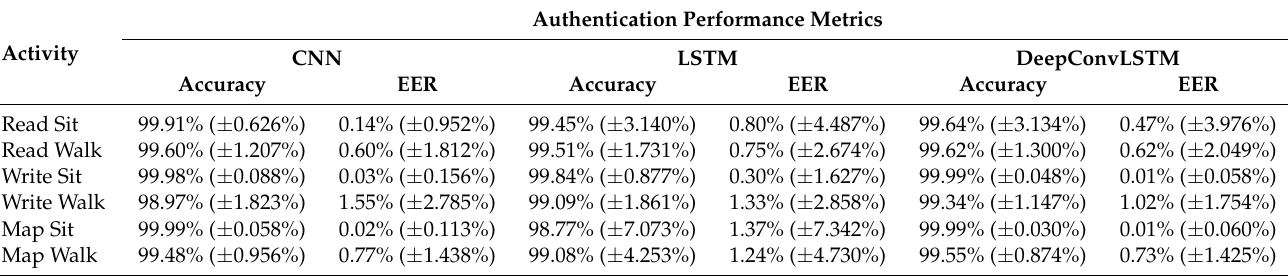
Table 10. Average metrics on classifier evaluation of deep learning models using HMOG dataset.